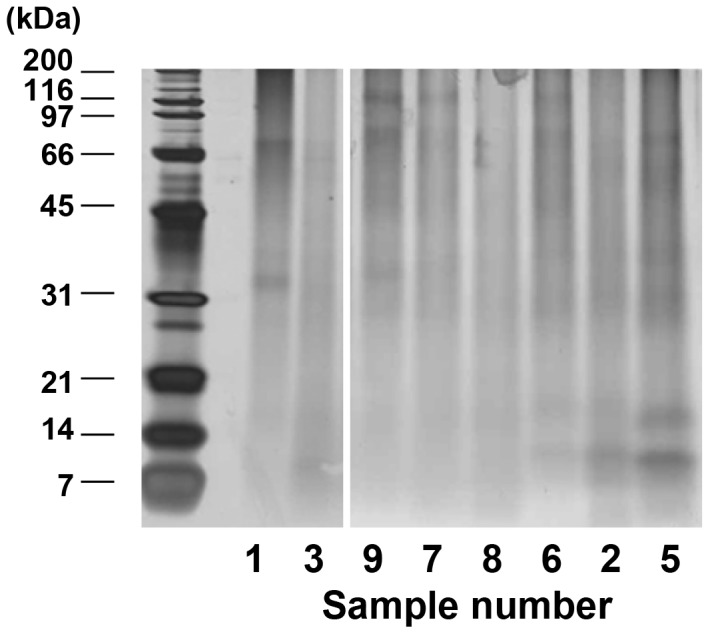
Analysis of proteins extracted from CaOx kidney stones by SDS-PAGE.CaOx kidney stones obtained from 8 individuals were solubilized, dialyzed, concentrated, and then the extracts containing 0.2 µg protein each were subjected to SDS-PAGE. Proteins were visualized by silver staining. Sample 4, the yield of which was <0.1 µg/mg stone, also showed similar diffused protein pattern (data not shown). Electrophoresis and staining were carried out three times, and all gave similar results.